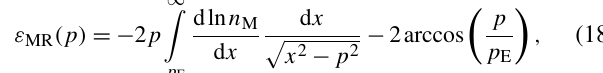
Figure 5. Reflection over ocean.